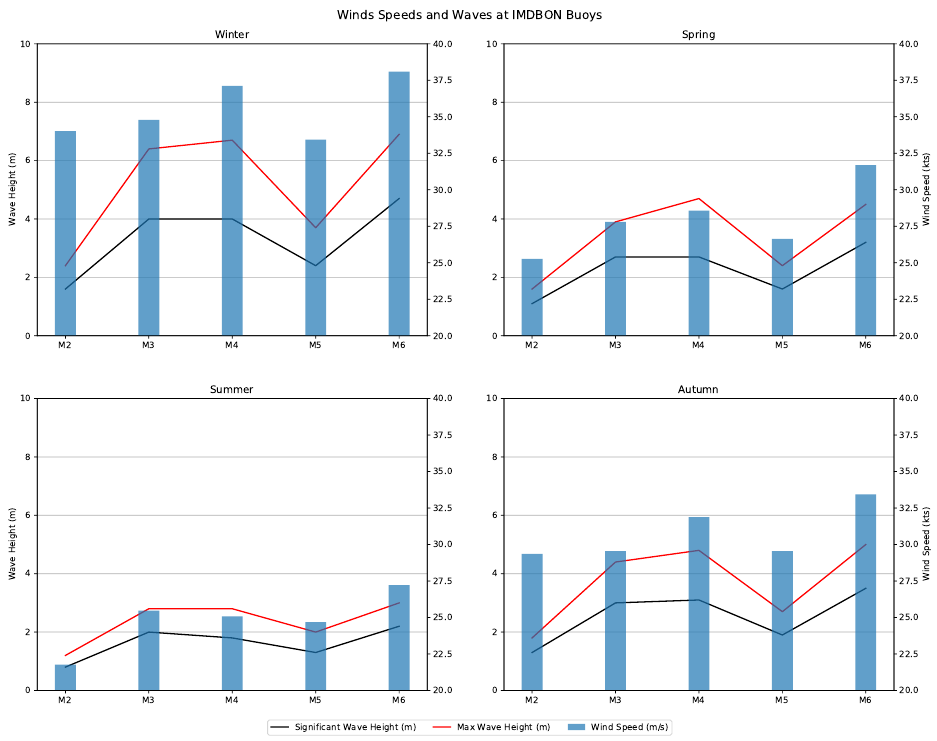
Figure 2. Seasonal mean wind speed, significant wave height and maximum wave height from each of the IMDBON buoys. Note that maximum wave height data was only available from the 2nd generation of the network. Strong seasonal and spatial variability is evident, with Winter being the most active season. M2 and M5 are more sheltered from the Atlantic; although they do experience comparable winds, their wave heights are far smaller than those experienced at M3 for example. This is due to Ireland’s landmass blocking storm waves and swell off the